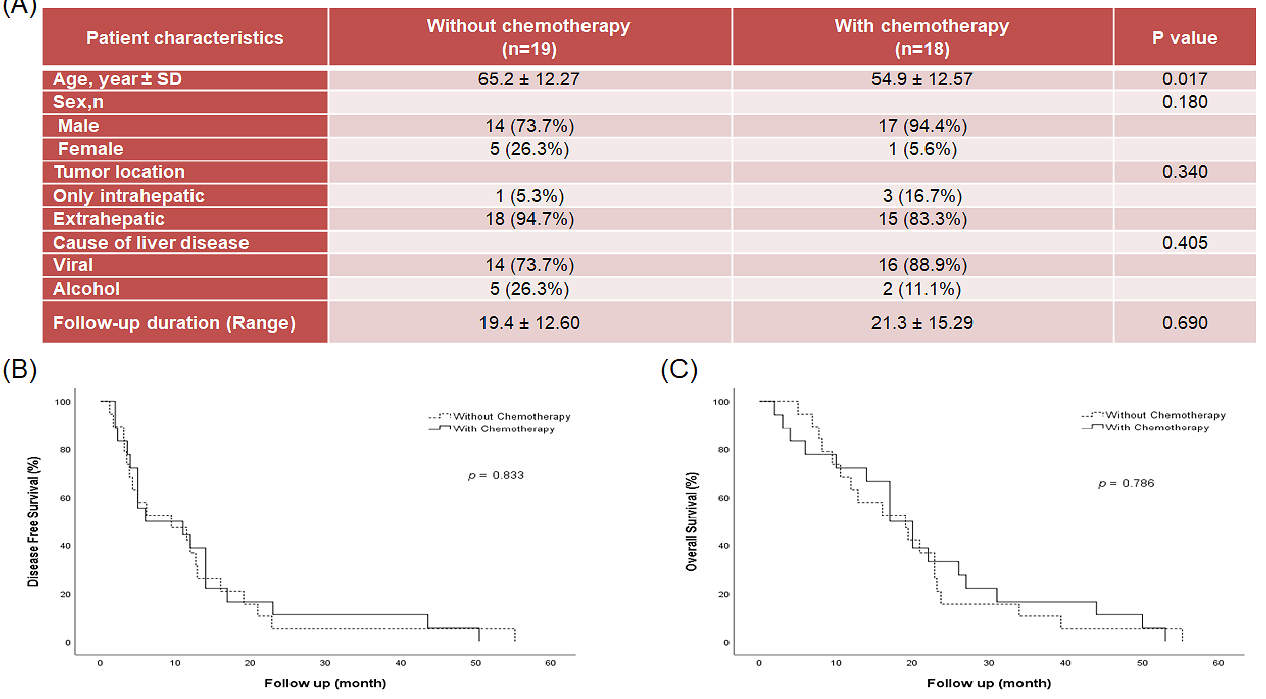
Figure 1. Information on patients with HCC after surgery with or without chemotherapy. ( A ) Patient characteristics and clinical features. ( B ) Disease-free survival rate after surgery with or without chemotherapy. ( C ) Overall survival rate after surgery with or without chemotherapy.